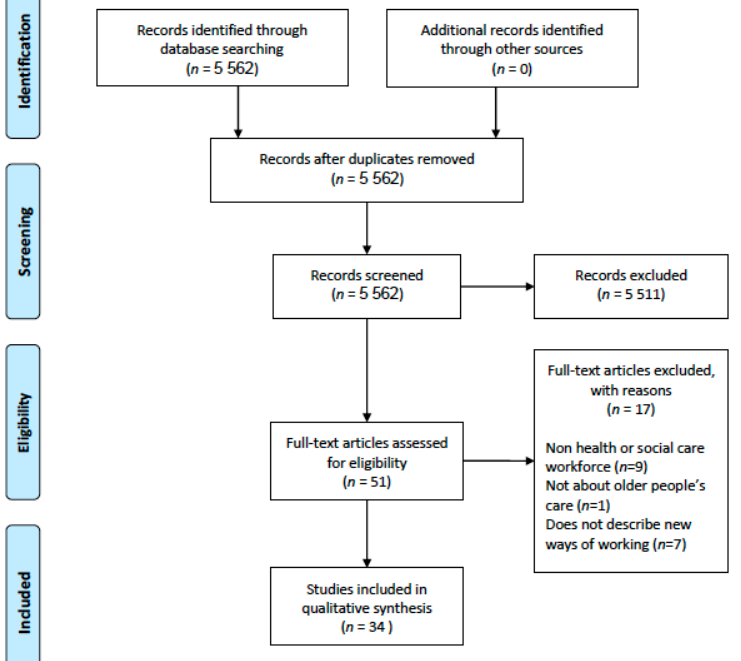
Figure 1. PRISMA Flow Diagram.